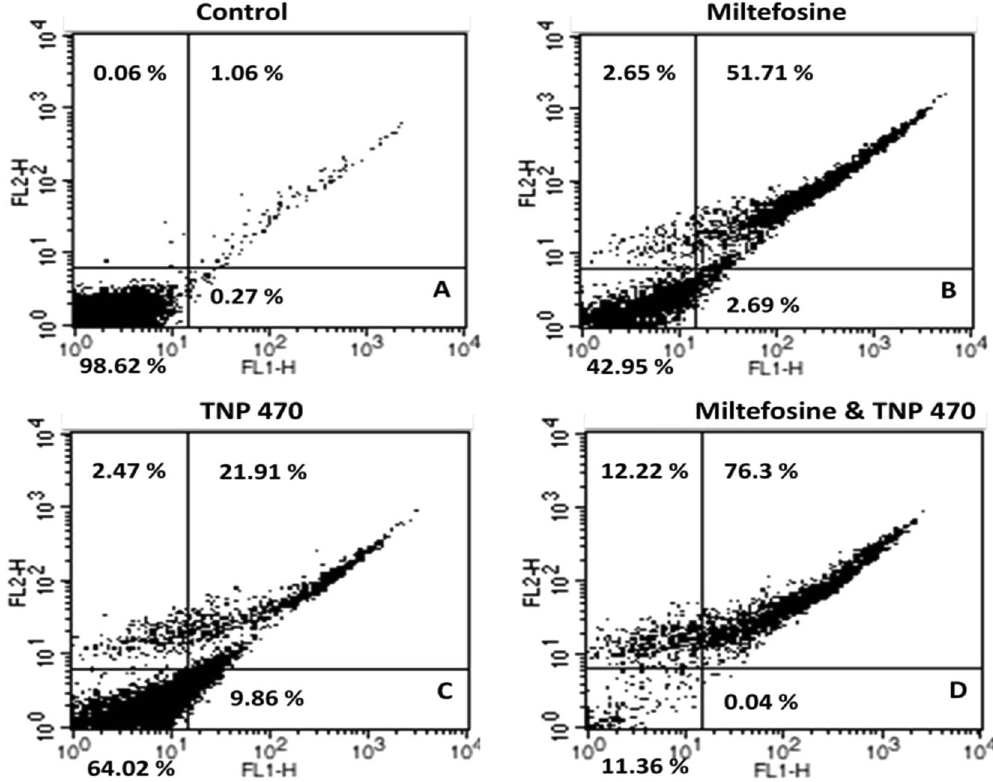
Figure 4. Externalization of phosphatidyl serine on plasma membrane, analysed by annexin V-FITC and PI staining. ( A ) Control promastigotes treated with 0.2% DMSO. ( B ) Promastigotes induced with 25 µ M of miltefosine. ( C ) Cells treated with 20 µ M of TNP-470. ( D ) Miltefosine induced promastigotes treated with TNP-